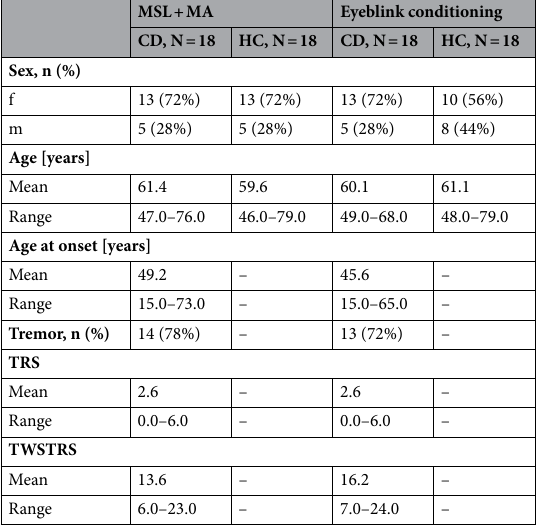
Table 1. Demographics of the study cohort. CD cervical dystonia, HC healthy controls, MSL motor sequence learning, MA motor adaptation, TWSTRS Toronto Western Spasmodic Torticollis Rating Scale, TRS Fahn– Tolosa–Marin Tremor Rating